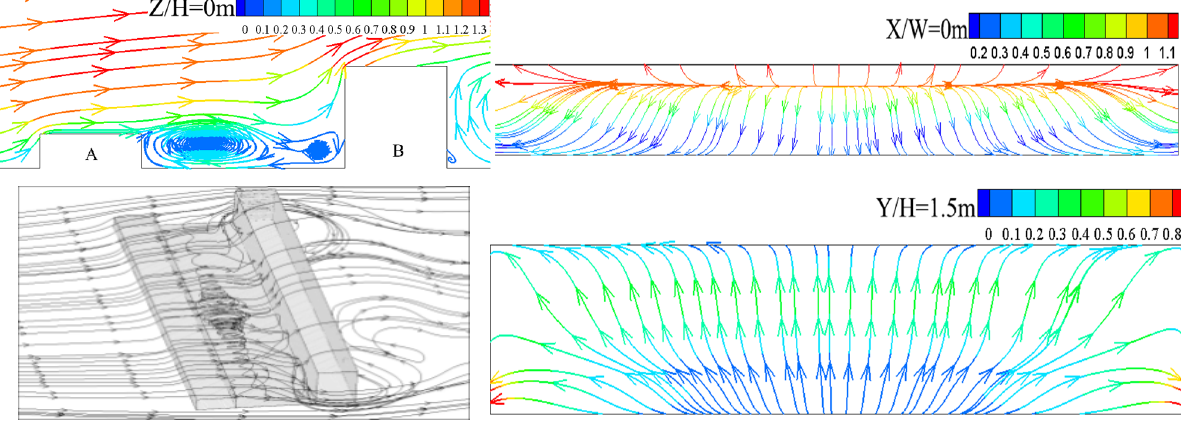
Figure 9. Plane streamline diagram and three-dimensional flow field diagram in the step-up street with an ASF = 1/3.